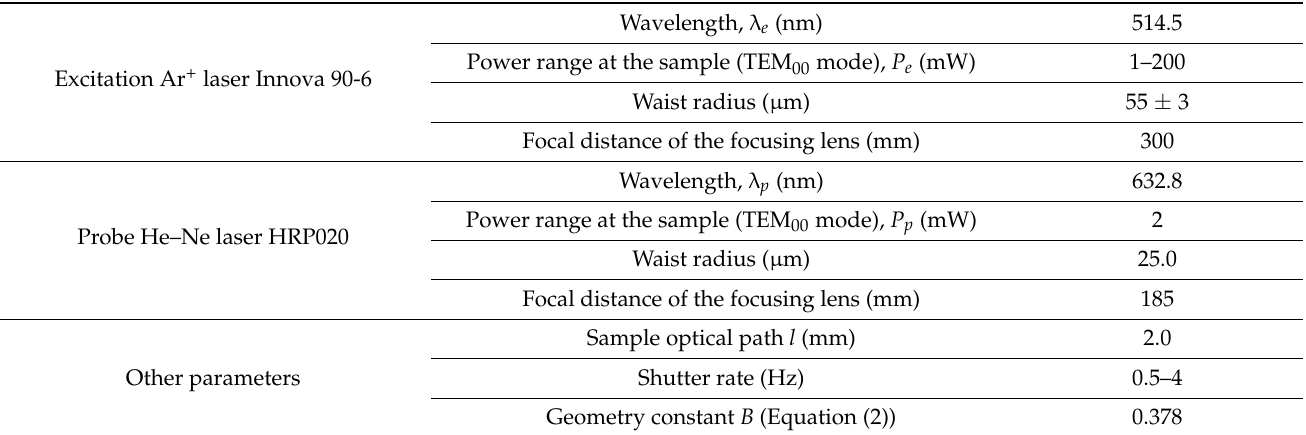
Table 3. Parameters of the thermal lens